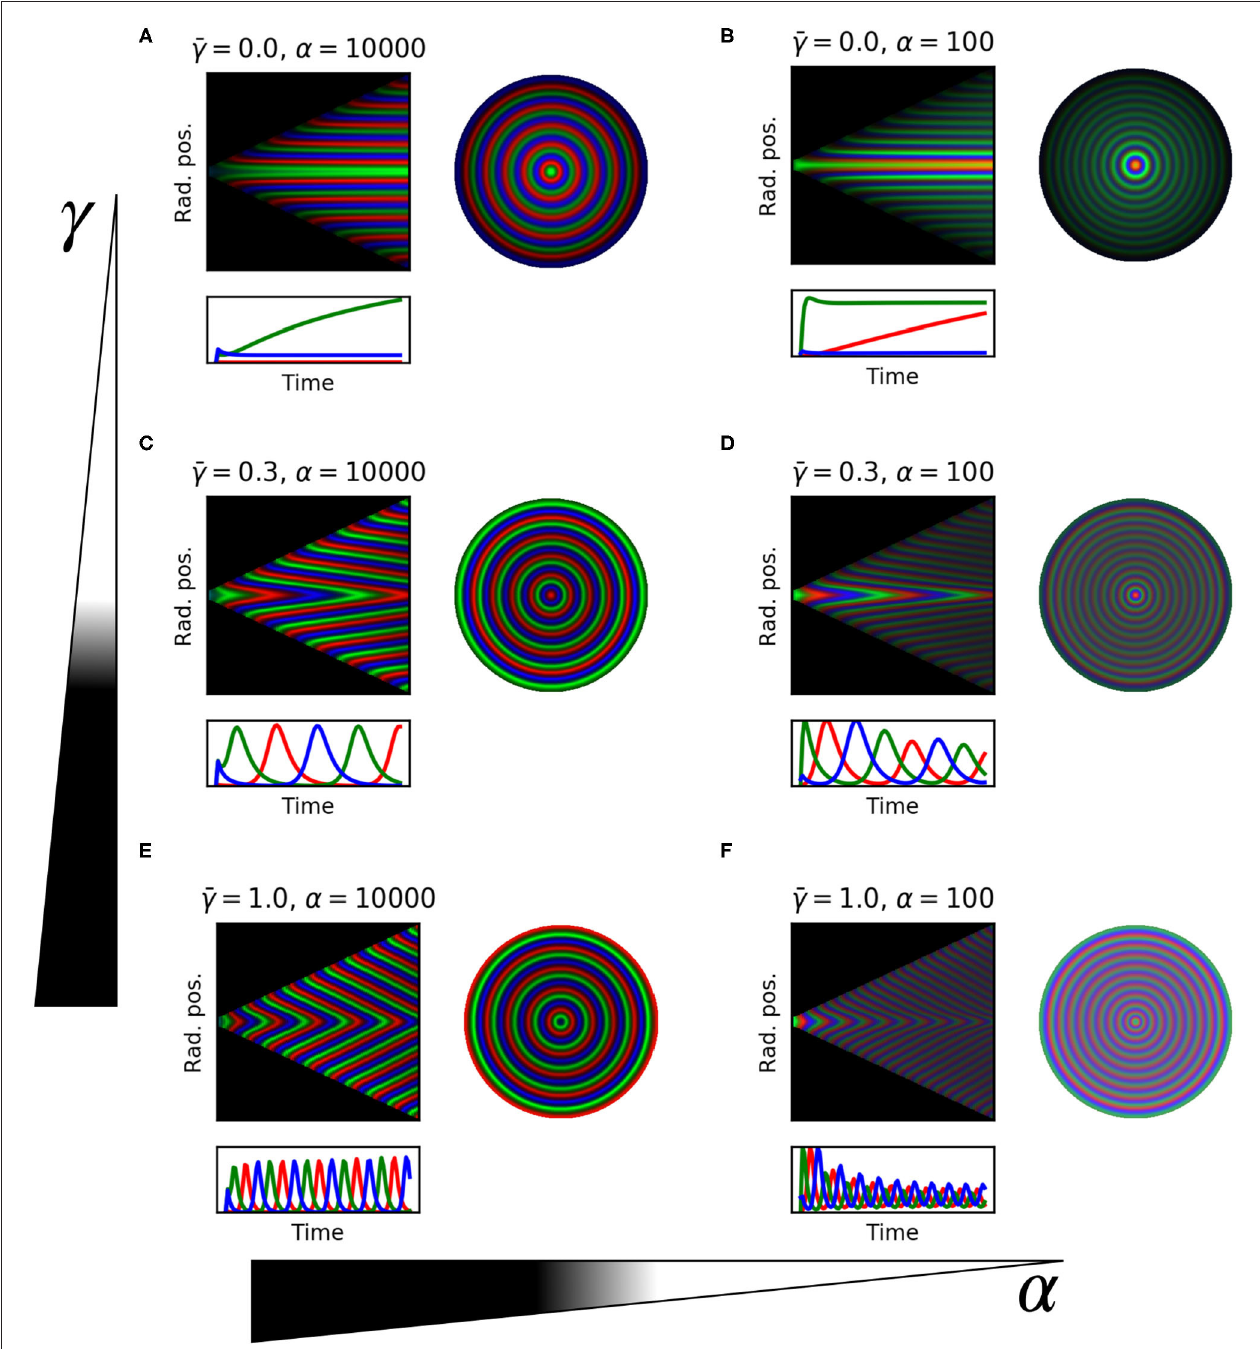
FIGURE 6 | 1D model simulations for selected parameters. Each panel shows: kymograph of the emerged pattern, where stripes show wave trajectories; trace of the three repressor concentrations over time in the center of the colony; the whole colony showing the final ring pattern. (A) ¯ γ = 0.0, α = 10,000. (B) ¯ γ = 0.0, α = 100. (C) ¯ γ = 0.3, α = 10,000. (D) ¯ γ = 0.3, α = 100. (E) ¯ γ = 1.0, α = 10,000. (F) ¯ γ = 1.0, α = 100.